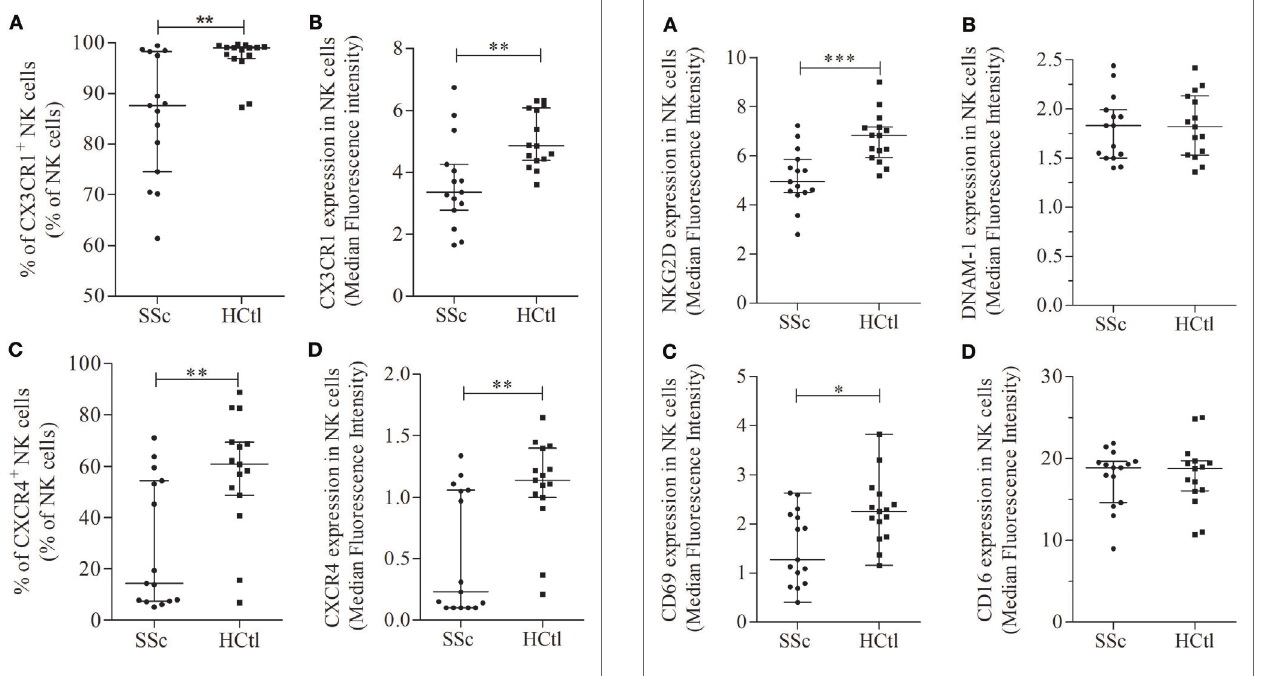
FigUre 4 | Chemokine receptors expression in natural killer (NK) cells in systemic sclerosis (SSc) patients. CX3CR1 (a,b) and CXCR4 expression levels and percentages (c,D) were assessed with flow cytometry analysis in whole NK cell from SSc patients ( n = 15) in comparison with healthy controls (HCtl) ( n = 15). Results were expressed as percentages of positive cells among NK cells (a,c) and median fluorescence intensity (b,D) . Results were depicted as median ± interquartile range. Statistical difference was established using Mann–Whitney U test. ** p <